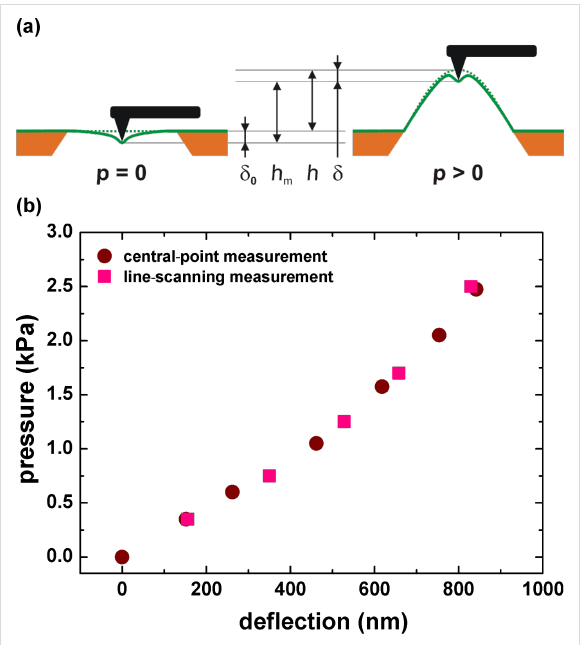
Figure 2: (a) Schematic of the central-point method in the bulge test; (b) Comparison of the line-scanning and the central-point method in the bulge